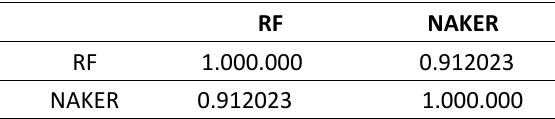
Table 3: Correlation Matrix Test Result